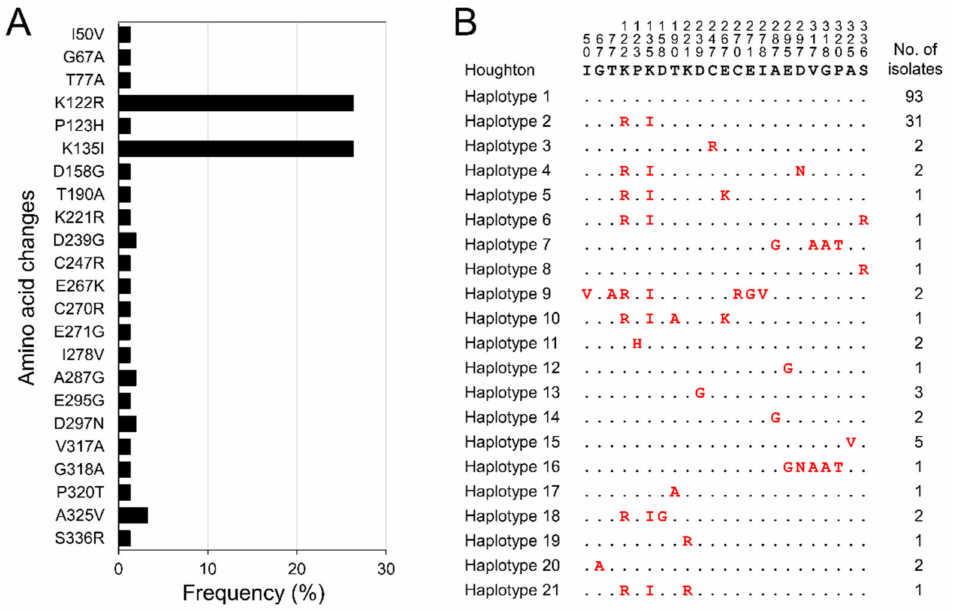
Figure 1. Amino acid sequence polymorphisms of etmic2 in Korean E. tenella isolates. ( A ) Amino acid changes. A total of twenty-three amino acid changes were detected in Korean etmic2 . ( B ) Haplotype diversity. Twenty-one distinct haplotypes were identified in 156 Korean etmic2 sequences. The dots represent residues identical to the reference sequence of the Houghton strain (XM_013377912.1). Amino acid changes at particular amino acid positions are indicated as